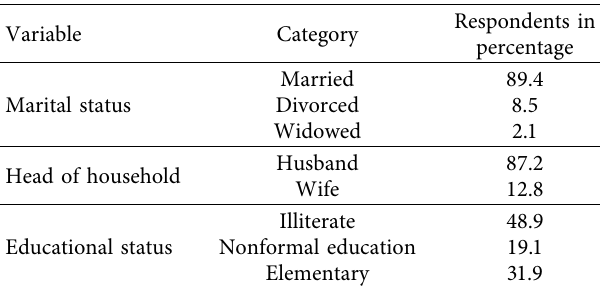
Table 3: Marital status, household head, and educational status of